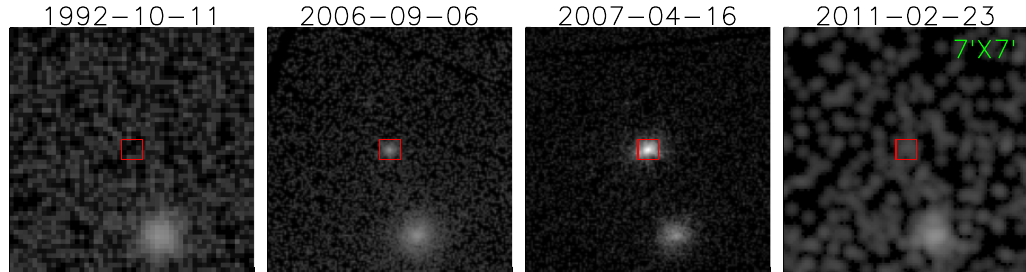
Figure 1. The count images of 2XMMi J184725.1-631724 (red box) from four X-ray observations. The first one is from ROSAT , the middle two are from XMM-Newton / MOS1 and the last one is from Swift / XRT. The bright extended source at the bottom of each image is from the giant cD elliptical IC 4765, which is expected to be steady and can be used as reference for comparison.